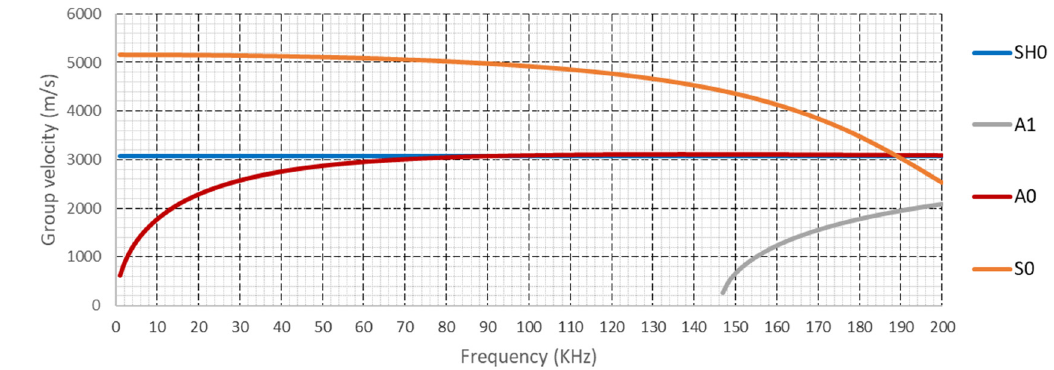
Figure 4. Group velocity dispersion curves for U-pile.